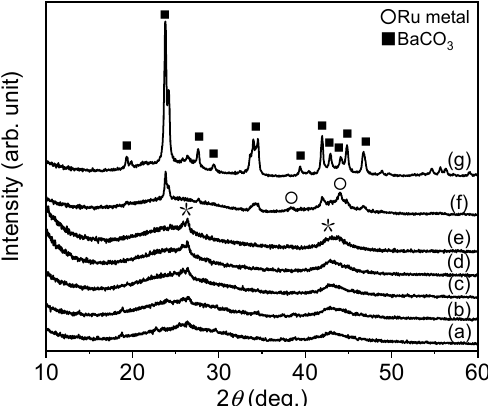
Figure 5. Wide-angle XRD patterns of the used Ba-Ru catalysts and reference materials—( a ) 1.6Ba-10Ru / MPC, ( b ) 1Ba-10Ru / MPC, ( c ) 0.5Ba-10Ru / MPC, ( d ) 0.1Ba-10Ru / MPC, ( e ) 10Ru / MPC, ( f ) 1.6Ba-10Ru / AC, and ( g ) 1.6Ba / MPC. The “asterisk” peaks arise from the carbon